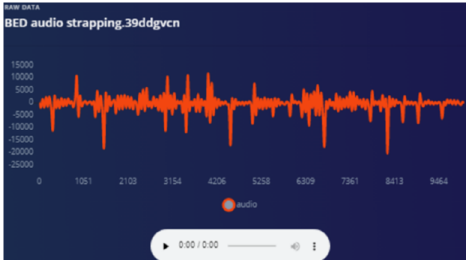
Figure 20. Audio sensor is strapped—waveform smoother.